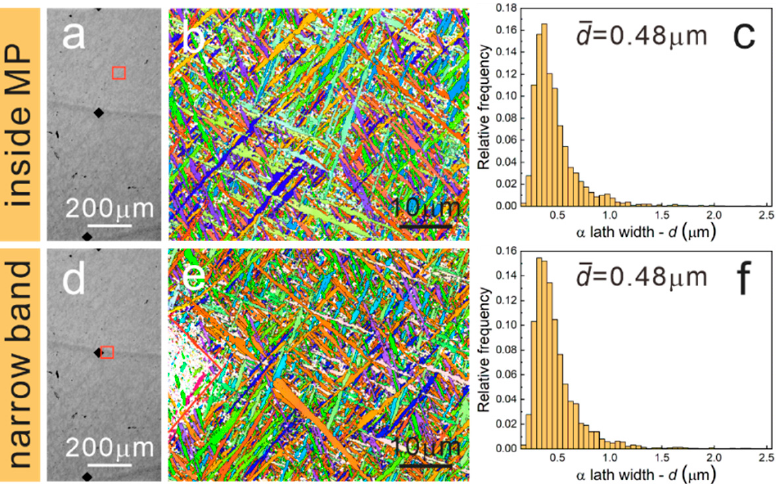
Figure 9. OM images and corresponding inverse pole figures (IPFs), α lath width distribution of the EPT9 sample: ( a – c ) narrow band, ( d – f ) inside the MP. (The black diamonds are the marking inden- tations of wide bands, and the red square is the EBSD scanning region).